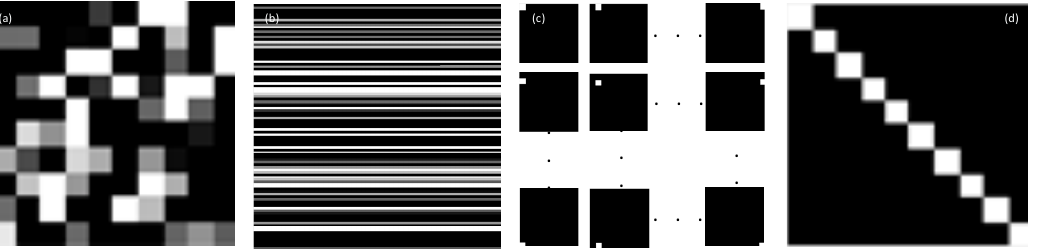
Figure 1. Difference between low rank and low texture. ( a ) high-texture image block, ( b ) low-rank high-texture matrix, ( c ) low-texture image blocks, ( d ) full-rank low-texture matrix.